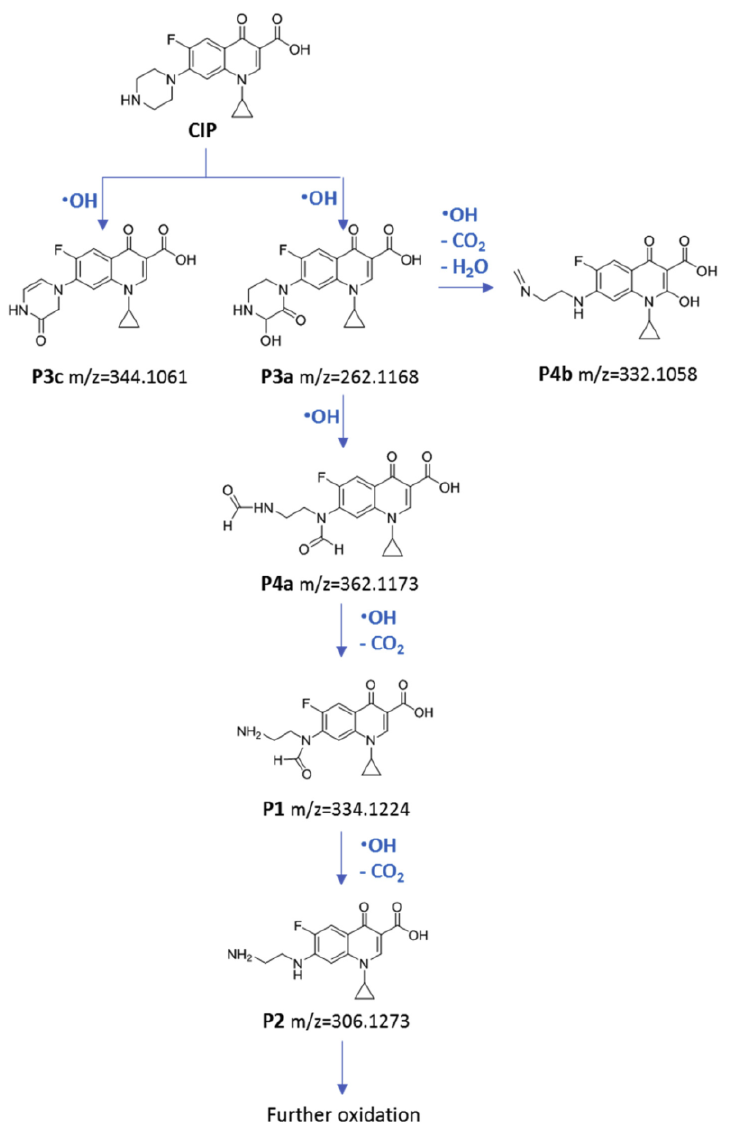
Figure 12. Proposed CIP degradation pathway in the visible-light photocatalytic oxidation with g-C 3 N 4 nanosheets, based on the detection of intermediate decomposition byproducts. Reproduced with permission from ref. [63]. Copyright 2020 Elsevier.